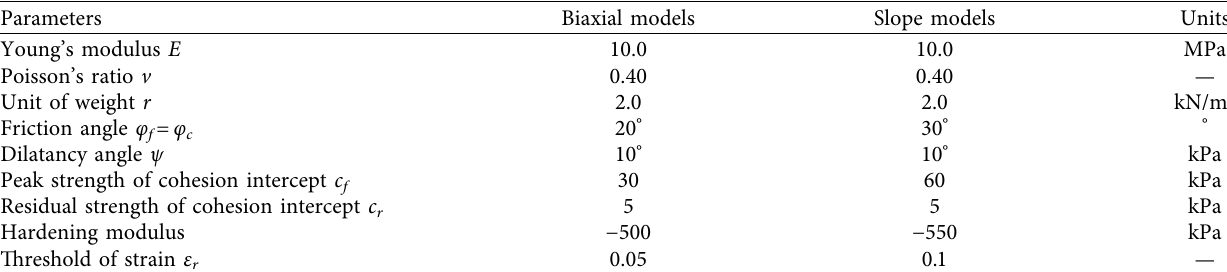
Figure 3: Flow chart of the computational program. Table 1: Material parameters for the strain-softening Mohr–Coulomb constitutive model.